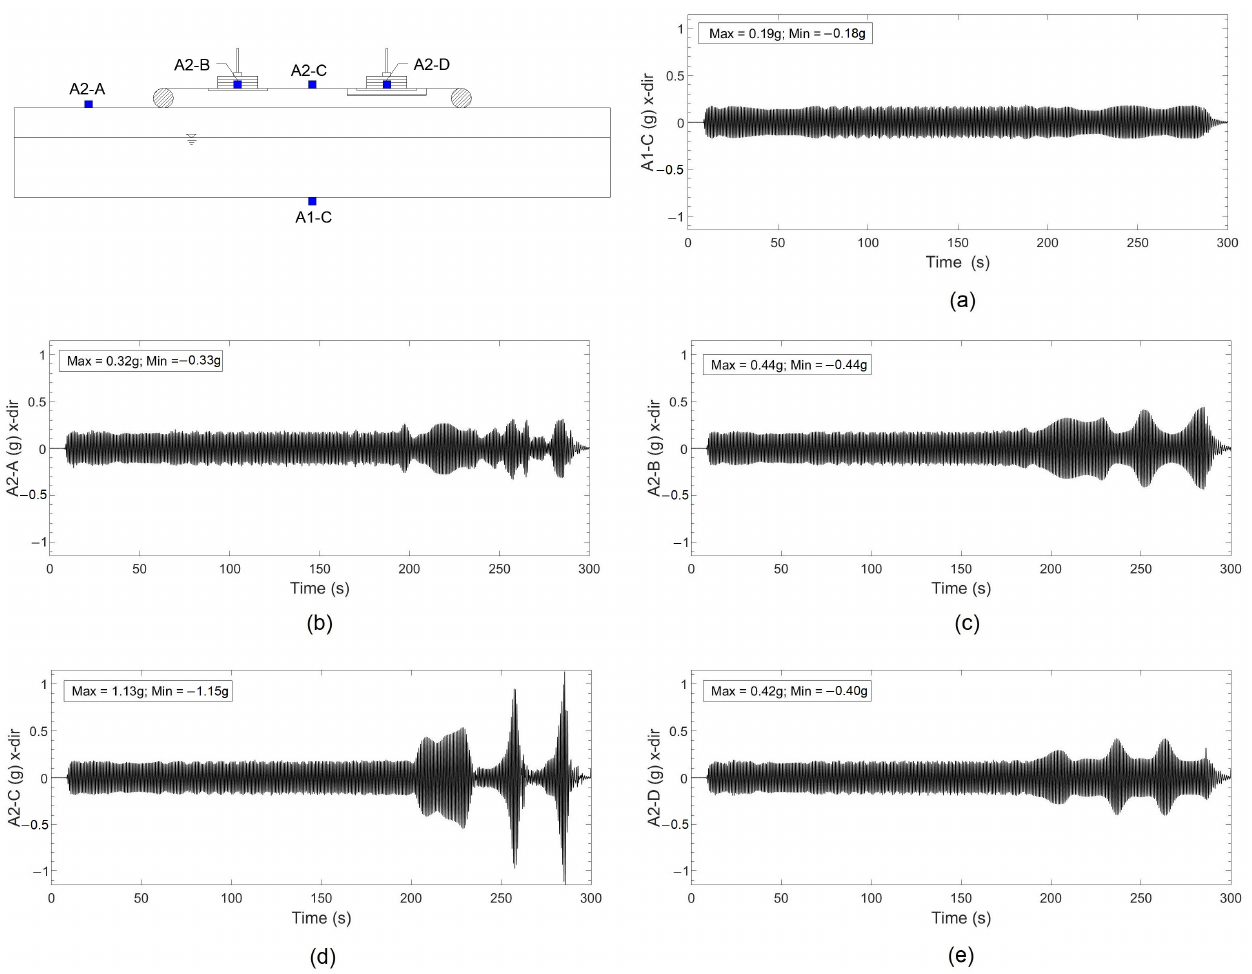
Figure 14. Recorded horizontal accelerations: ( a ) A1-C, ( b ) A2-A, ( c ) A2-B, ( d ) A2-C, and ( e ) A2-D.